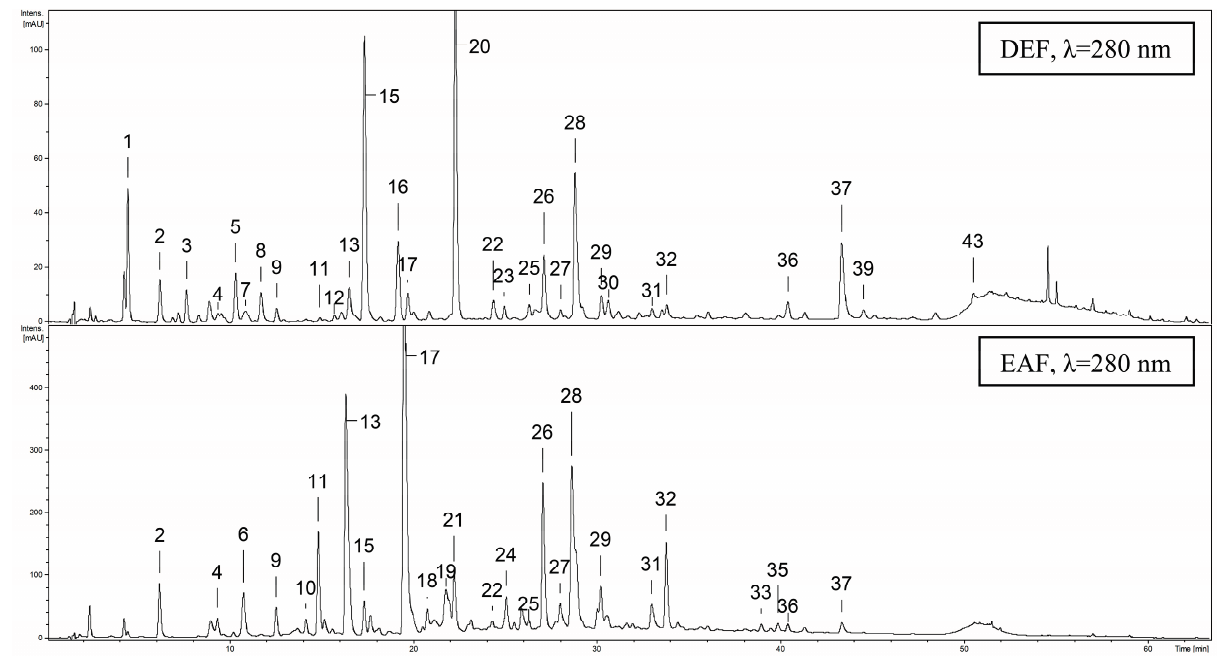
Figure 4. Representative UHPLC-UV chromatograms of diethyl ether (DEF) and ethyl acetate (EAF) extracts. Peak numbers refer to those implemented in Table